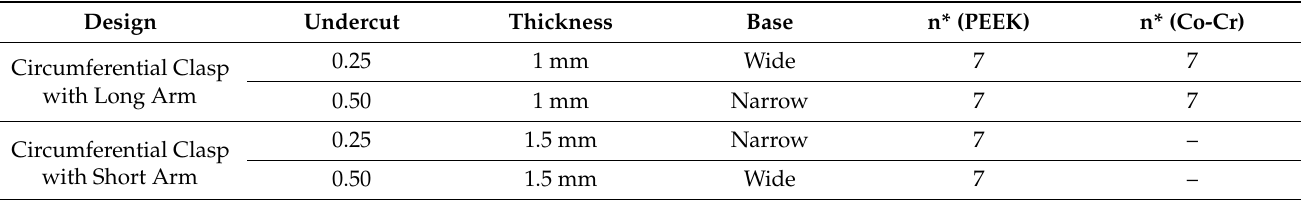
Table 1. The clasps’ design and sample distribution.